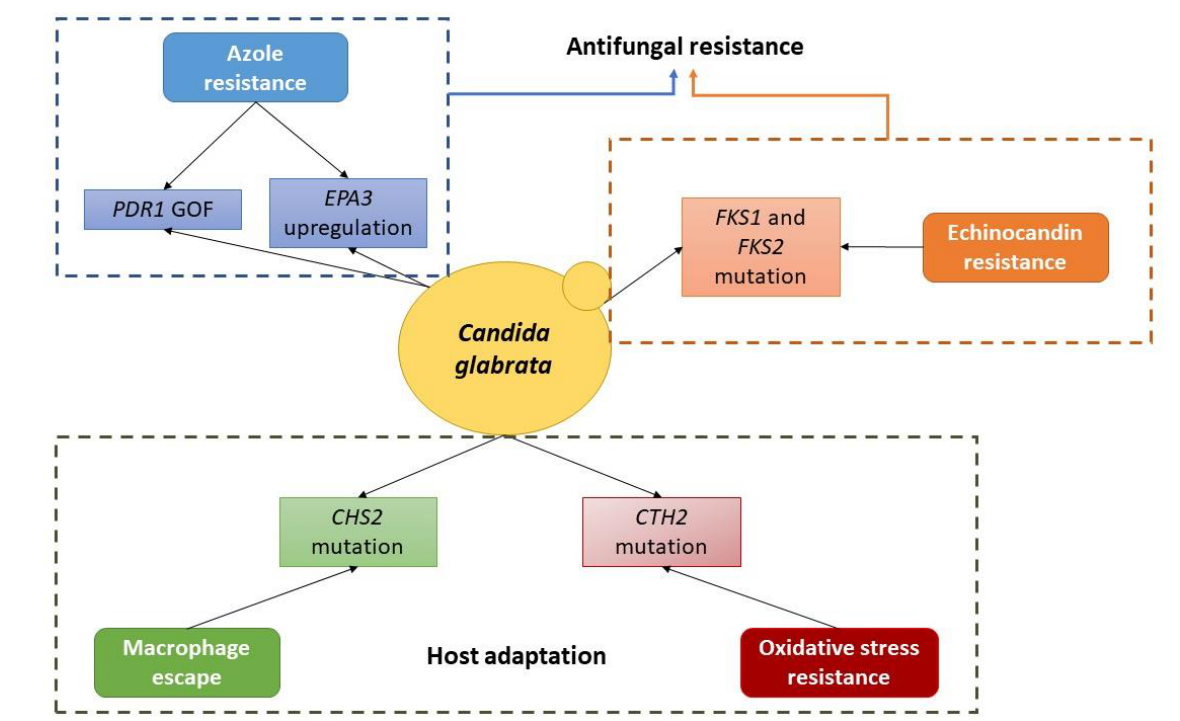
FIGURE 1: Schematic depiction of the currently known molecular basis of evolution towards antifungal resistance and host adapta- tion in C. glabrata